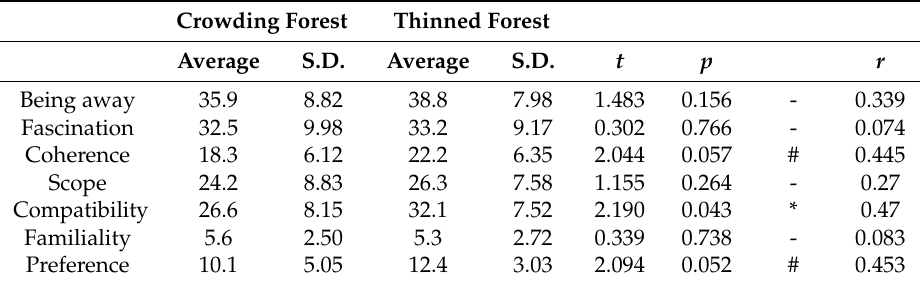
Table 6. T -test results for comparing the crowding and thinned settings using the PRS. Crowding Forest Thinned